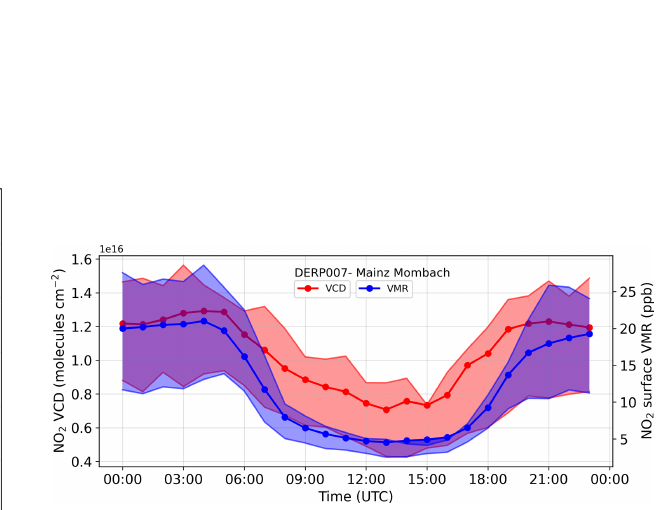
Figure C4. Mean hourly diurnal profiles of simulated NO 2 tro- pospheric VCDs (red) and surface volume mixing ratios (blue) at a background site (Mainz Mombach; 8.02 ◦ E, 50.02 ◦ N) for the model set-up UBA fl (diurnal variability of road transport and non- industrial combustion sectors not considered). The solid line and markers represent the mean, while the shaded region shows the inter-quartile variability